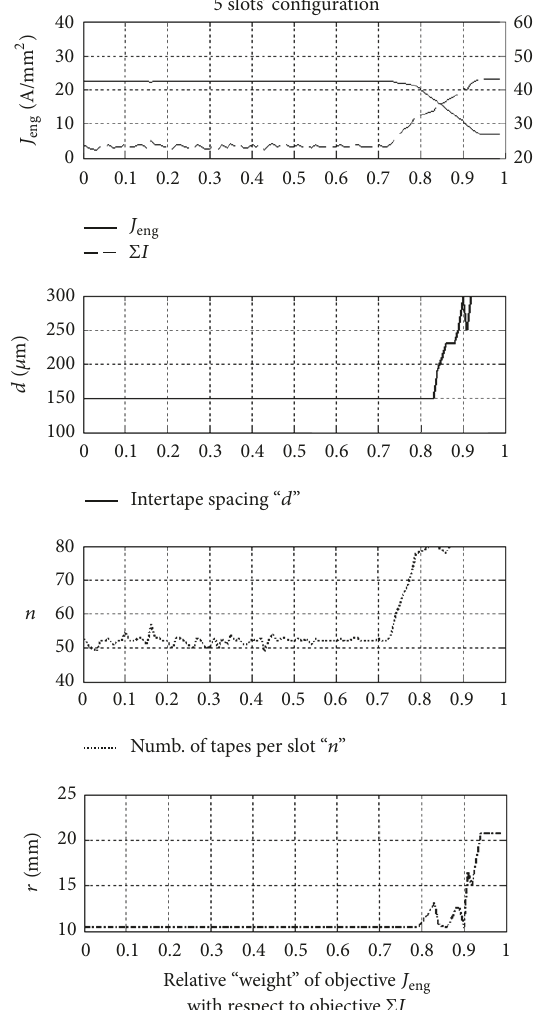
Figure 10: Pareto frontier represented as a function of the relative “weight” of one objective with respect to the other for the 6 slots’ = 6) . Top panel: values of the two objectives. configuration (𝑛 slots Bottom panels: values of the respective design